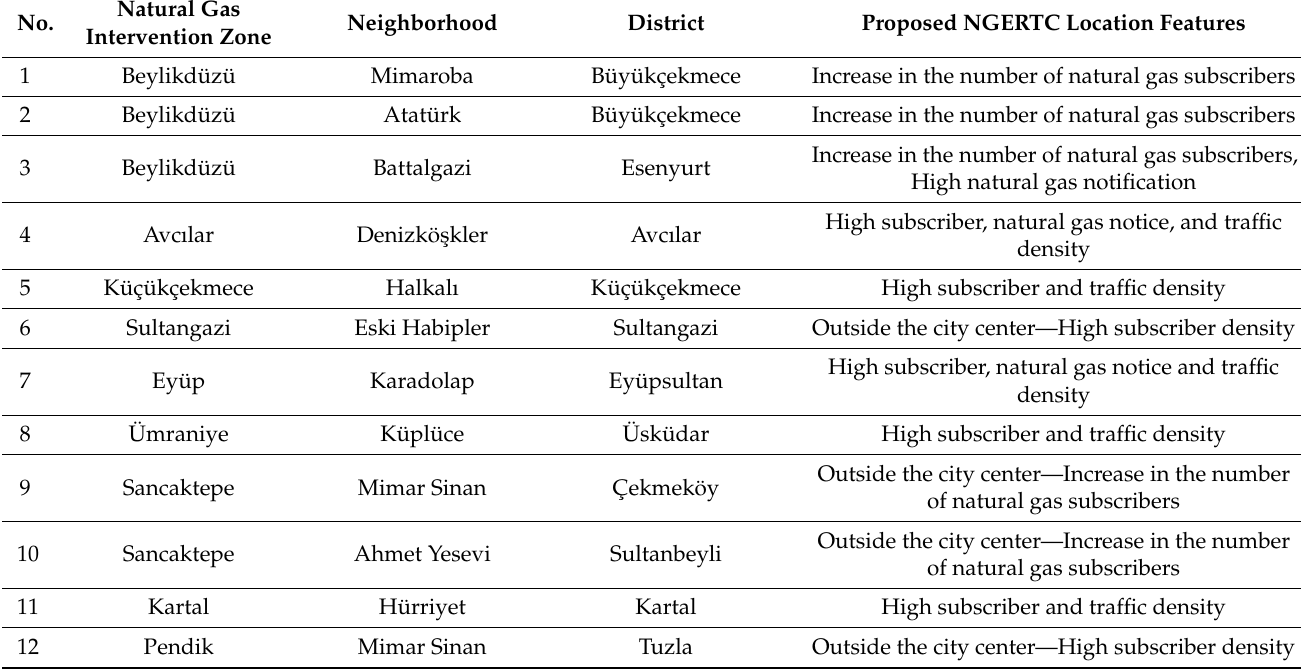
Figure 14. Suitability map for proposed new NGERTC locations. Table 7. Locations of proposed NGERTCs and their